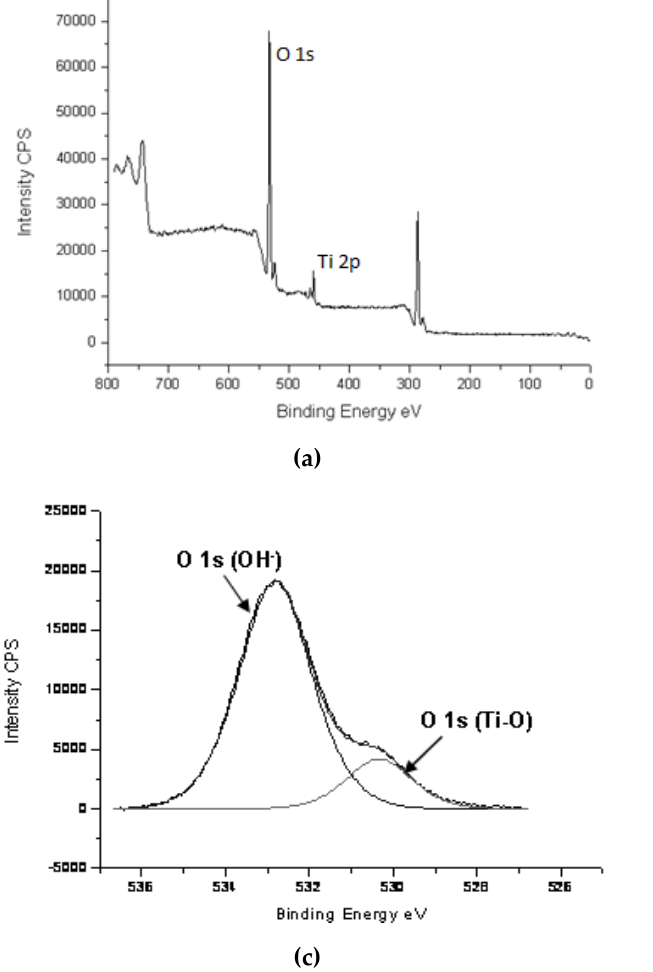
Figure 4. X-ray photoelectron spectra of the materials catalyst. ( a ) XPS survey Mg K α photoelectron spectrum. ( b ) high- resolution XPS spectrum of the Ti 2p peaks. ( c ) High-resolution XPS spectrum of the O 1s peaks.